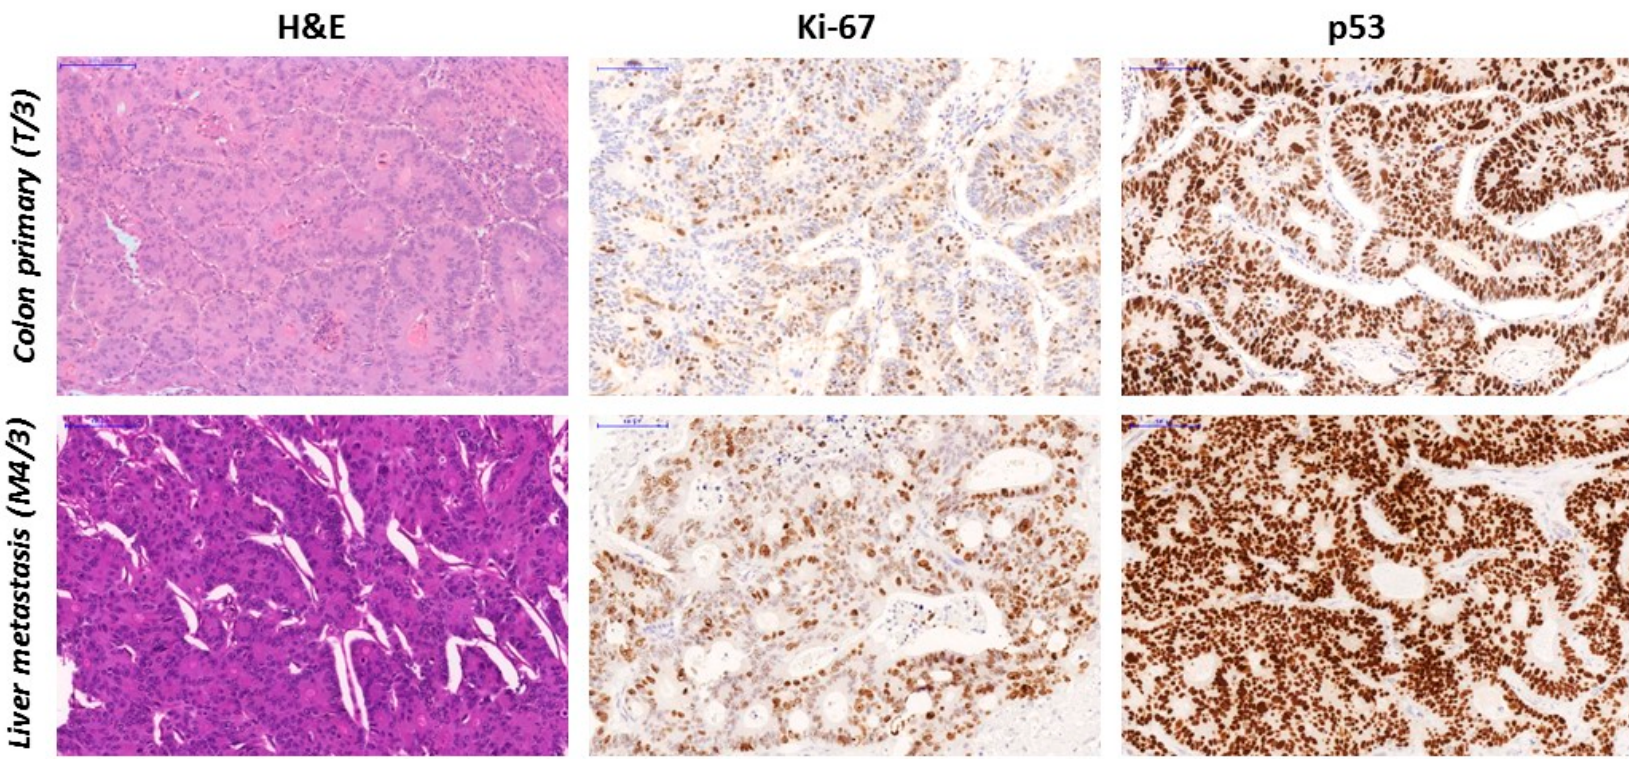
Figure 4. Conventional histology (H&E) and Ki-67and p53 immunohistochemistry of the primary colon adenocarcinoma sample T/3 and the late liver metastasis sample M4/3, removed 27 months after initial surgery. While the gross histological appearance (tubulo-glandular pattern with minimal foci of mucinous differentiation) of the tumor did not significantly change during the follow-up, a significant increase in cell proliferation was detected (20% vs. 40% Ki-67 labeling index, central panel). The positive p53 IHC status (generally strong positive cell nuclei, H-score = 230) of primary tumor T3 and obvious positivity (strong uniform nuclear positivity, H-score = 300) of the metastasis M4/3 (right panel) are both consistent with the respective TP53 genotype demonstrated by NGS. Microscope magnification: 20X.